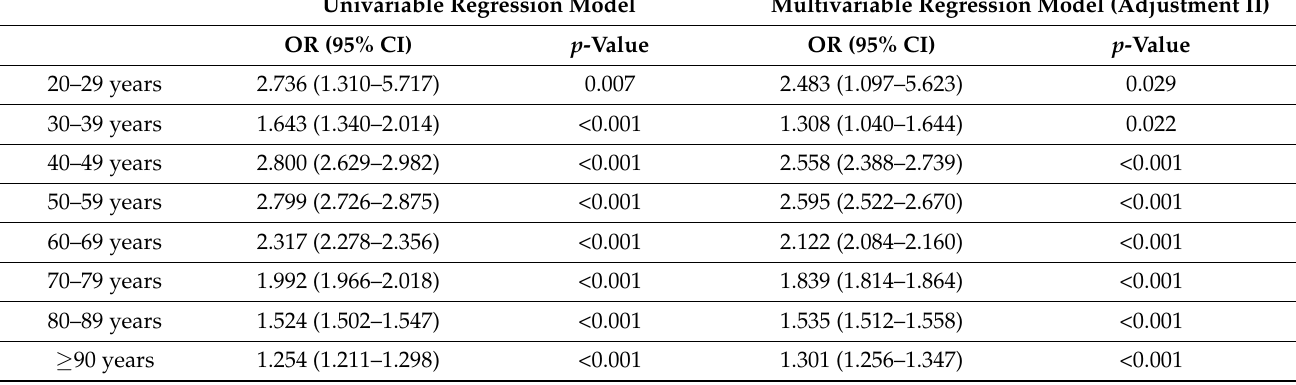
Table 5. Influence of diabetes mellitus on amputation in PAD patients (univariable and multivariable logistic regression